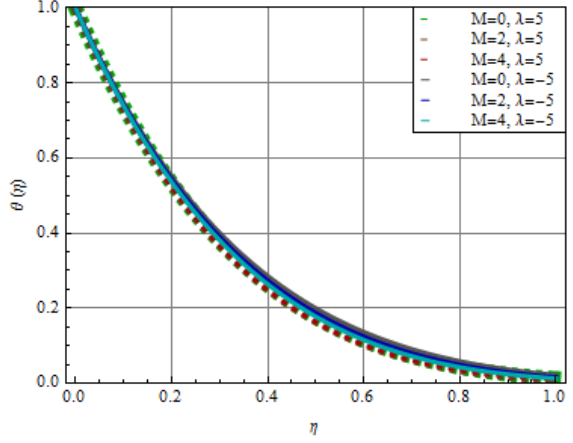
Fig. 6: The temperature distribution for alumina-sodium alginate nanofluid for different values of mixed convection and magnetic parameters with A = 0.5, U = 0.5, ε = 0, Pr = 6.2, ϕ = 0.2. w